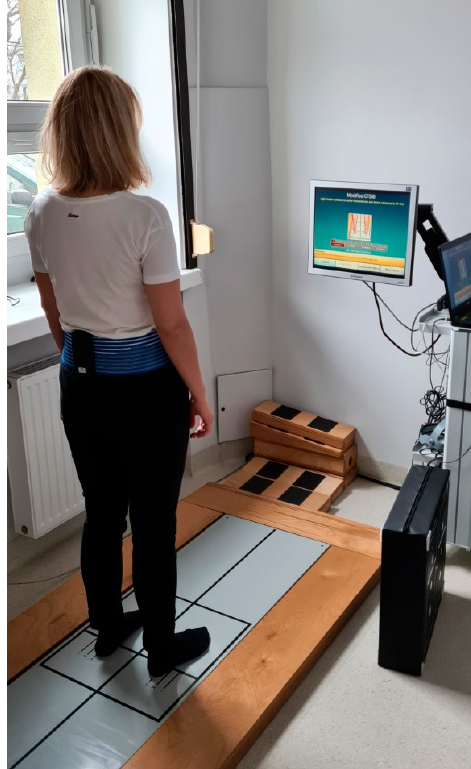
Figure 3. The study setup. The subject is standing in quiet stance on a static posturography plate, feet apart, with the MediPost device mounted in the lumbar area. Visual instructions are presented on the screen in front of the patient.